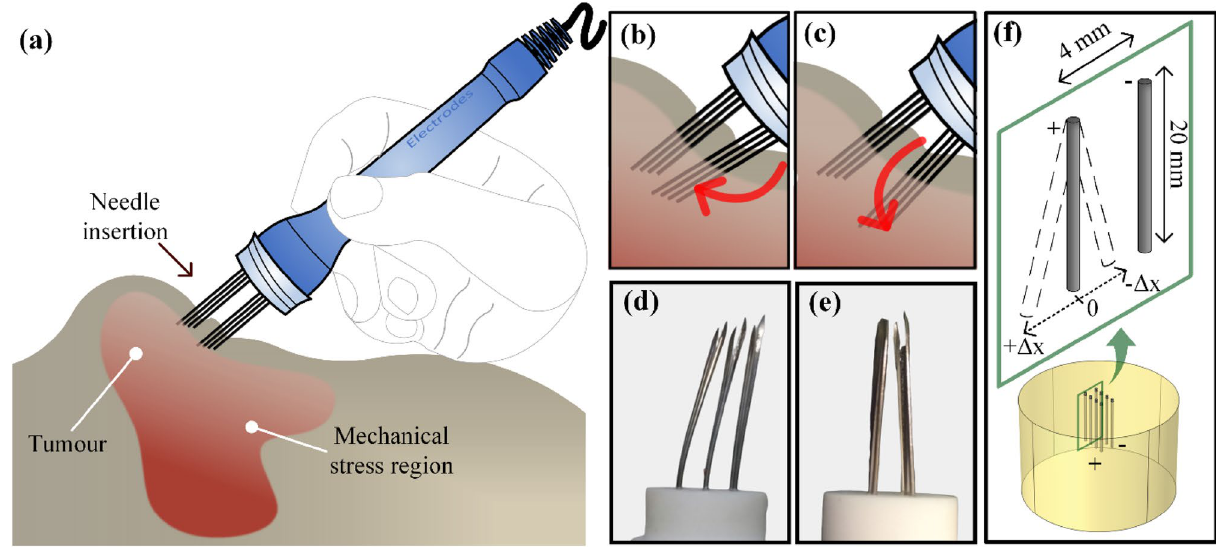
Figure 1. Illustration of electrode deflection in a mechanical stress region due to needle insertion. (a) The electrode insertion in stiff tissues may cause (b) an inward deflection or (c) an outward deflection. Two possible directions of needle deflection are shown. Illustrations were created in Microsoft VISIO Professional 2019 v.2111 (Microsoft Corporation, Washington, USA; https:// www. micro soft. com/ en- us/ micro soft- 365/ visio/ flowc hart- softw are) (d,e) are two cases of electrode deflection returned to electrode manufacture. (f) Numerical simulation geometry showing the ESOPE Type II electrode inserted into the tissue with standard